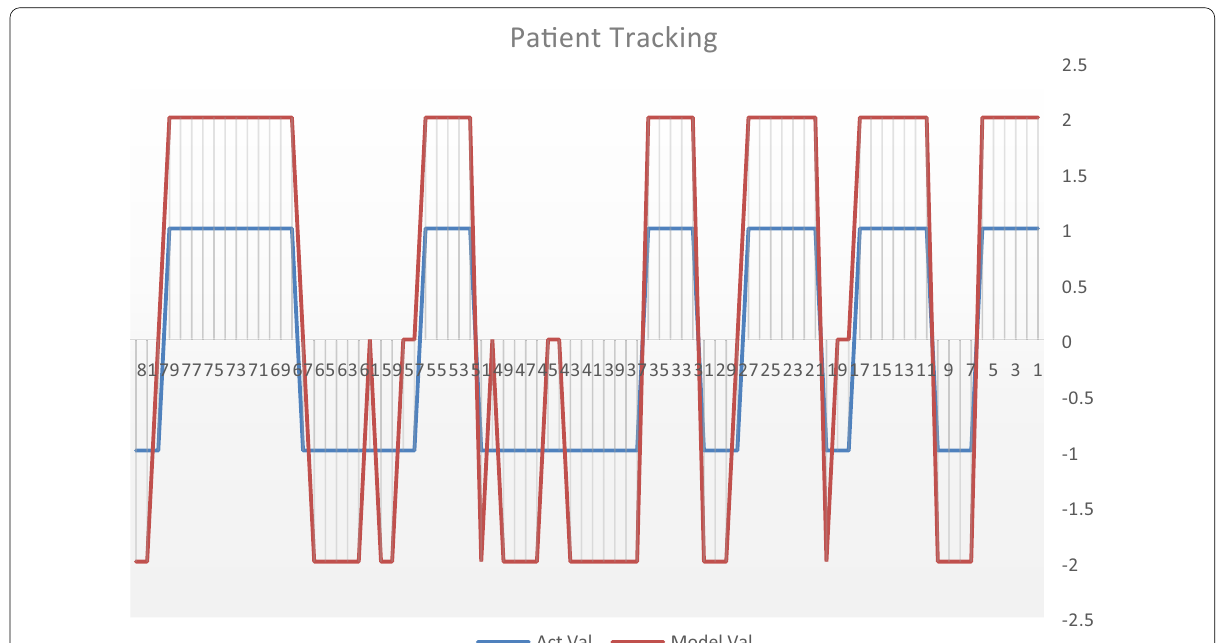
Fig. 6 Actual and predicted samples of the ensemble classifier in continuous